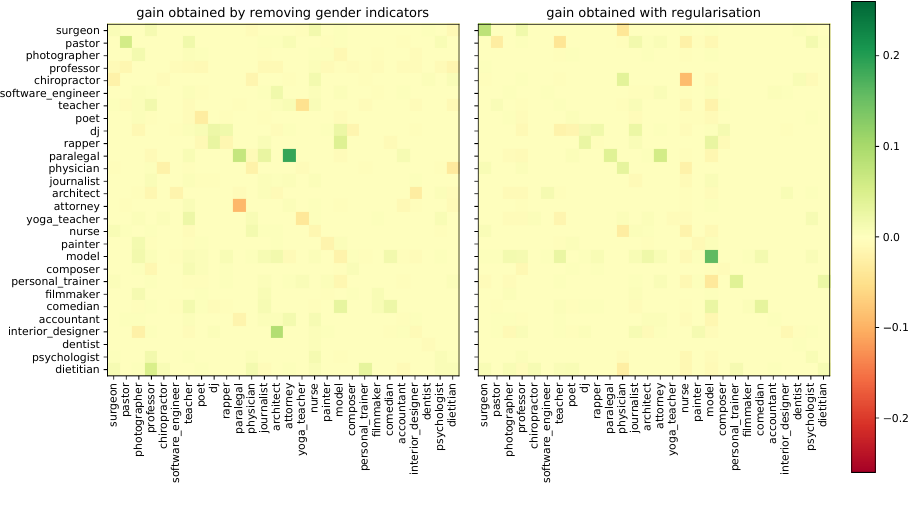
Figure A2. Extension of Figure 6 to all output classes of the Bios dataset and not only the most- frequent ones, which were selected in Figure 6 for readability